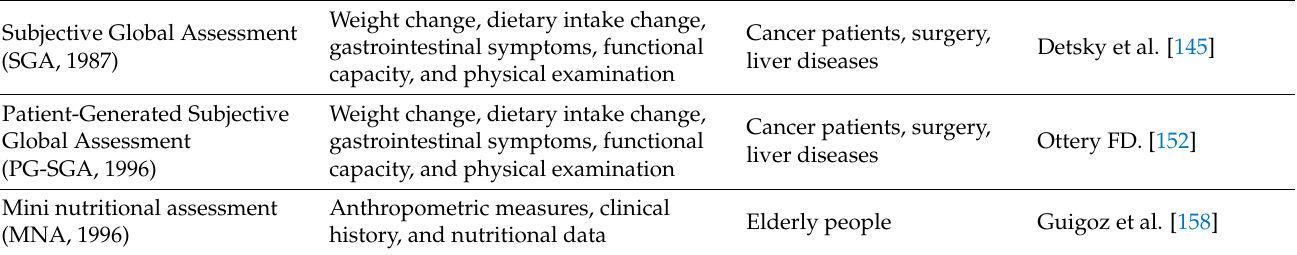
Table 8. Nutritional Assessment